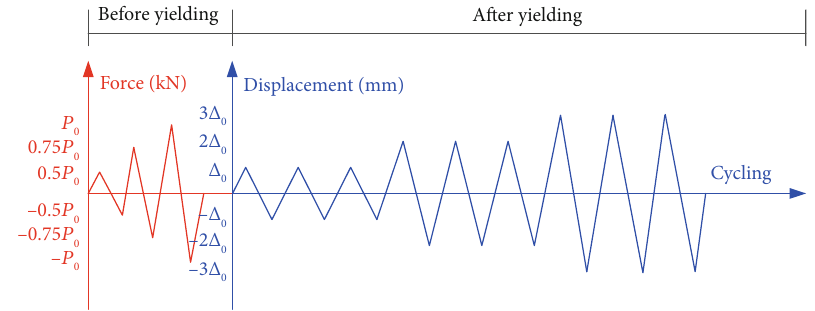
Figure 3: Column test setup.